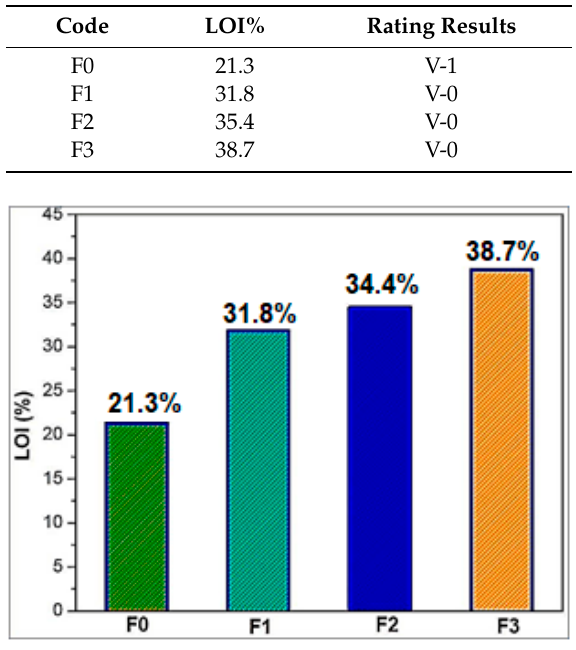
Table 2. Limit of oxygen index (LOI) and UL-94V ratings of composites.